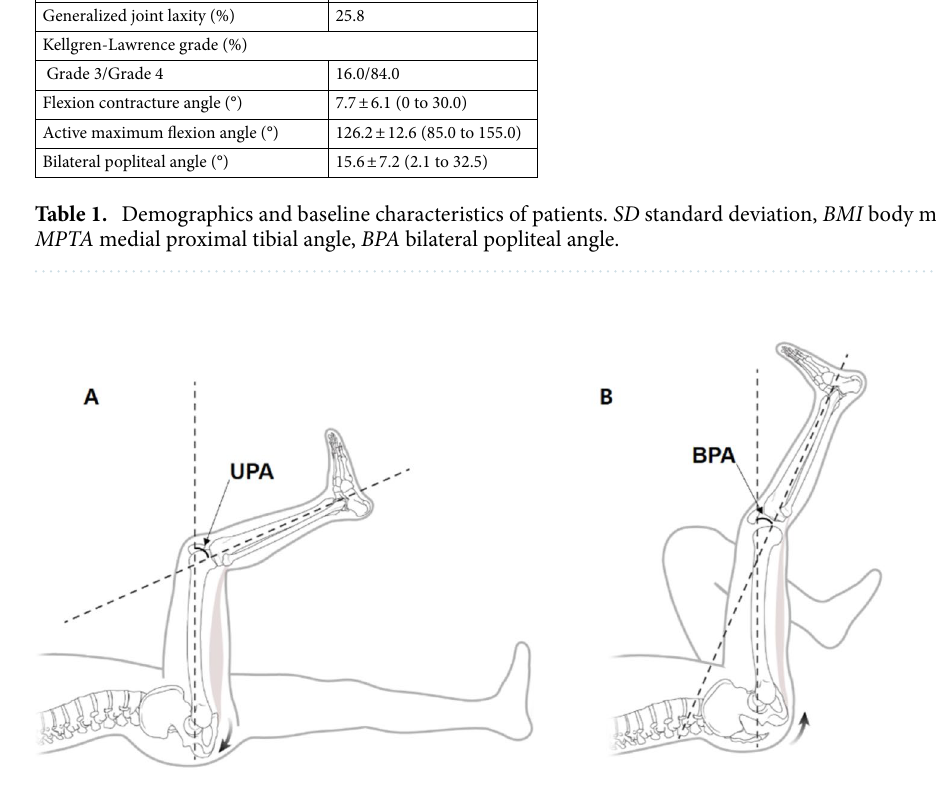
Figure 2. Popliteal angle was defined as the angle between the femoral extended line and tibia. (A) UPA was measured with the contralateral hips and knees extended. (B) BPA was measured with the contralateral hips and knees flexed to neutralize the anterior pelvic